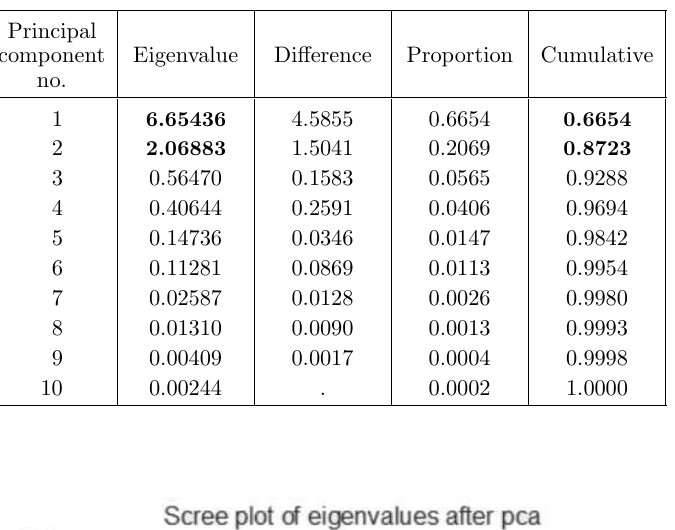
Table 8. Contribution of eigenvalues and principal components in total sample